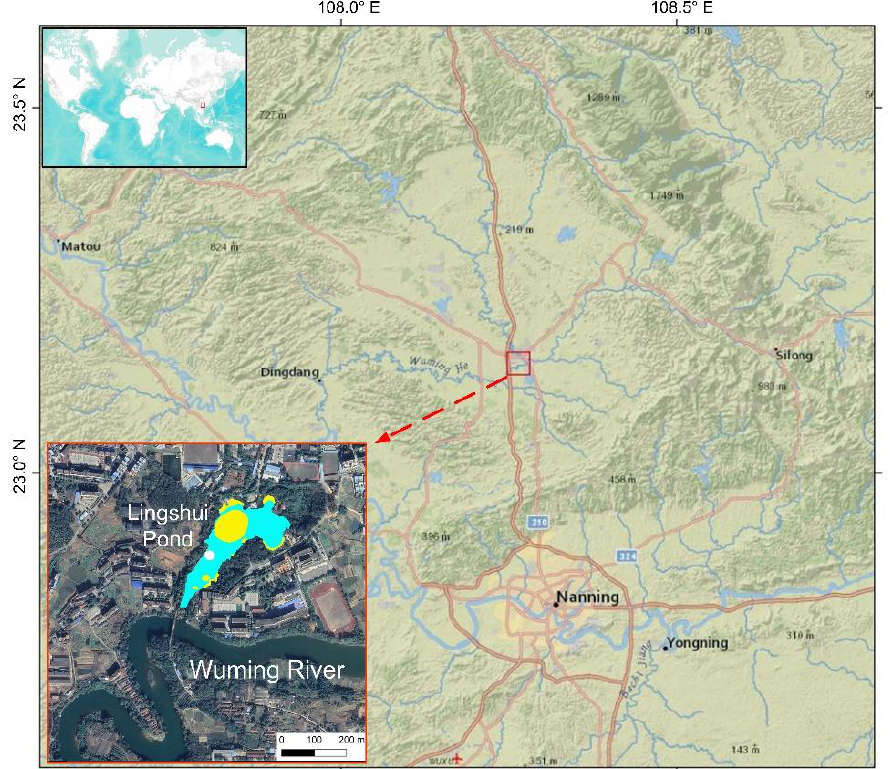
Figure 1. Topographic map of the Wuming Basin; the location of Lingshui Pool (LSP) is indicated by a red square. The white circle in the satellite photograph of LSP (bottom left) is the coring site, while the water area of LSP is marked blue. The area with significant loss of macrophytes, mainly Vallisneria natansin , in 2013 is marked yellow.